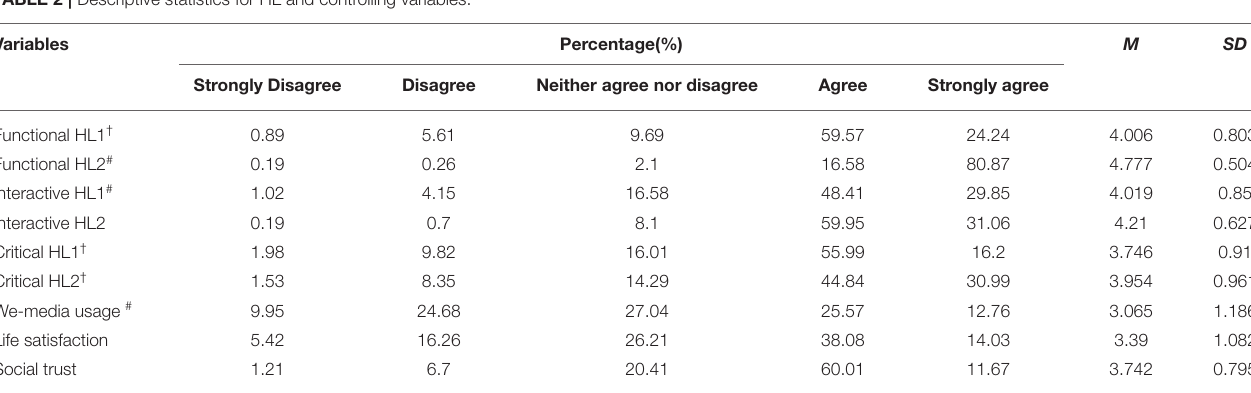
TABLE 2 | Descriptive statistics for HL and controlling